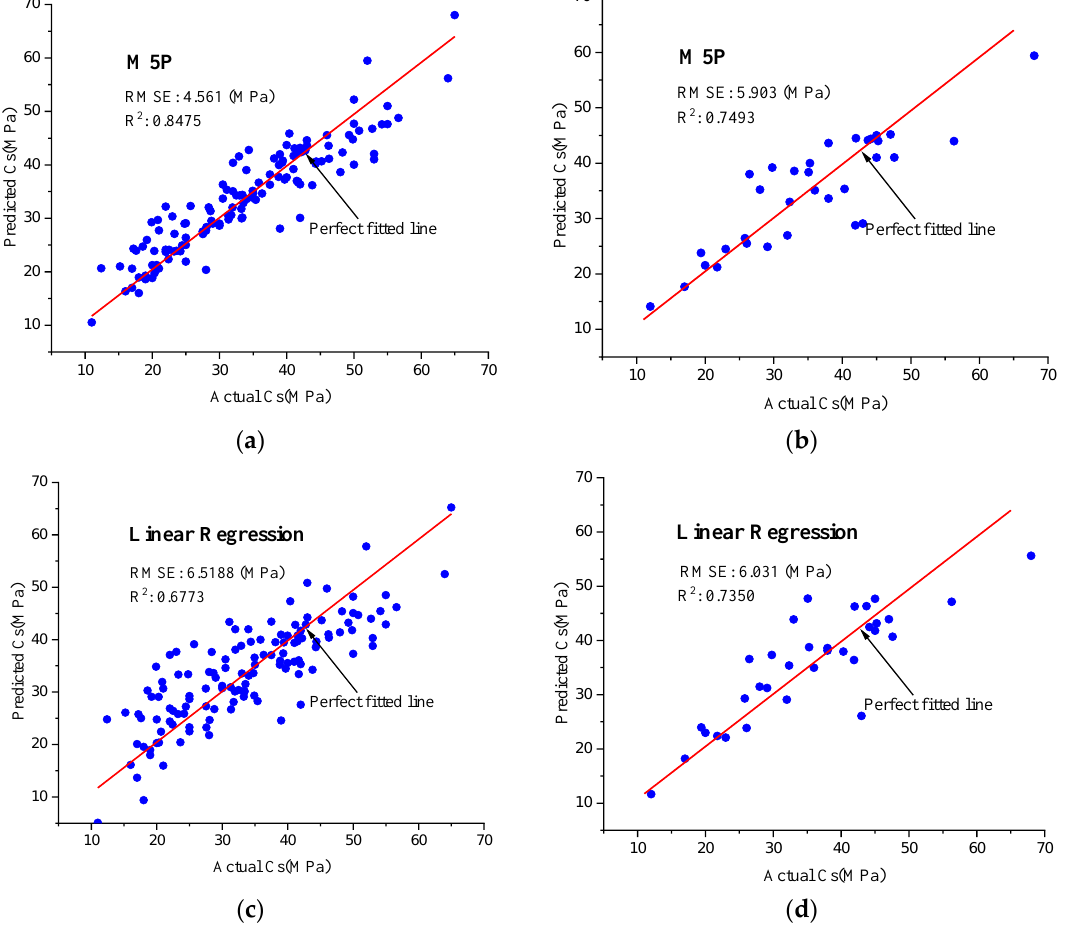
Figure 8. Results of the M5P and linear regression models for the testing and training datasets. ( a ) M5P training set. ( b ) M5P testing set. ( c ) Linear regression training set. ( d ) Linear regression testing set. Table 5. GSC-GBRT, linear regression, and M5P models ’ performance in predicting Cs for training and test datasets.